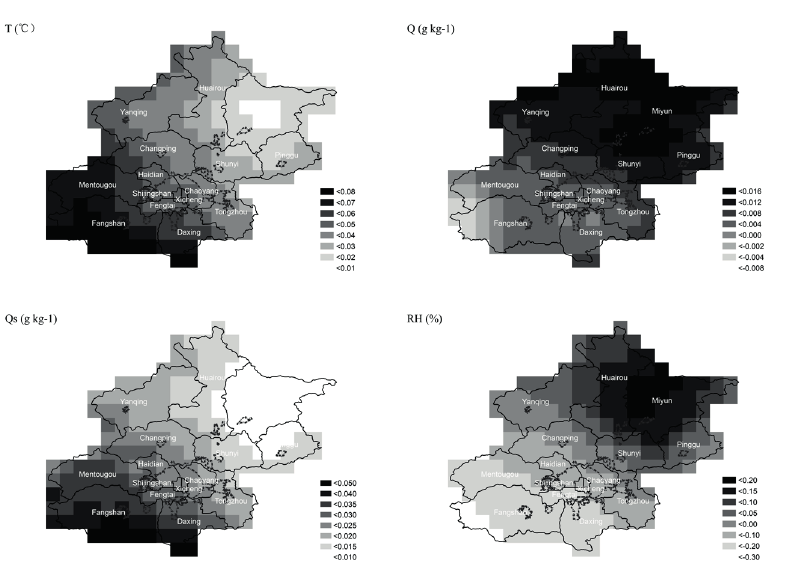
Fig. 3 Climatological annual-mean values of surface humidity and temperature based on 3-hour gridded data during 1979−2012.